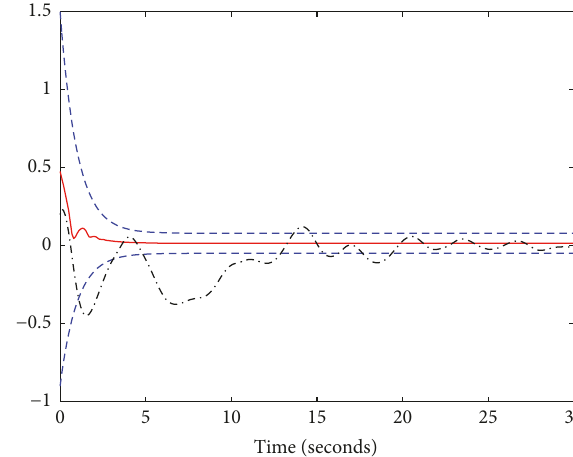
Figure 2: Angular position tracking error 𝑒 11 : ANC with error transformation method (—), ANC in [30] (- ⋅ - ⋅ ), and the error bounds (- - -).